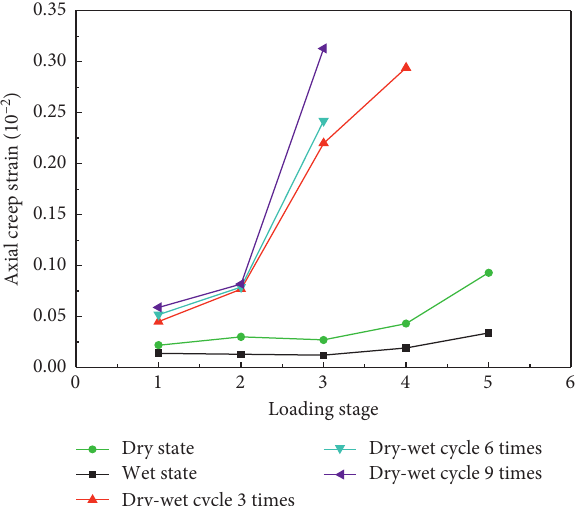
Figure 10: Creep strain changes of the specimens at each loading stage.